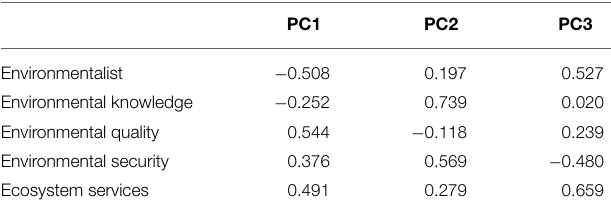
TABLE 1 | Principal component analysis (PCA) for the first three